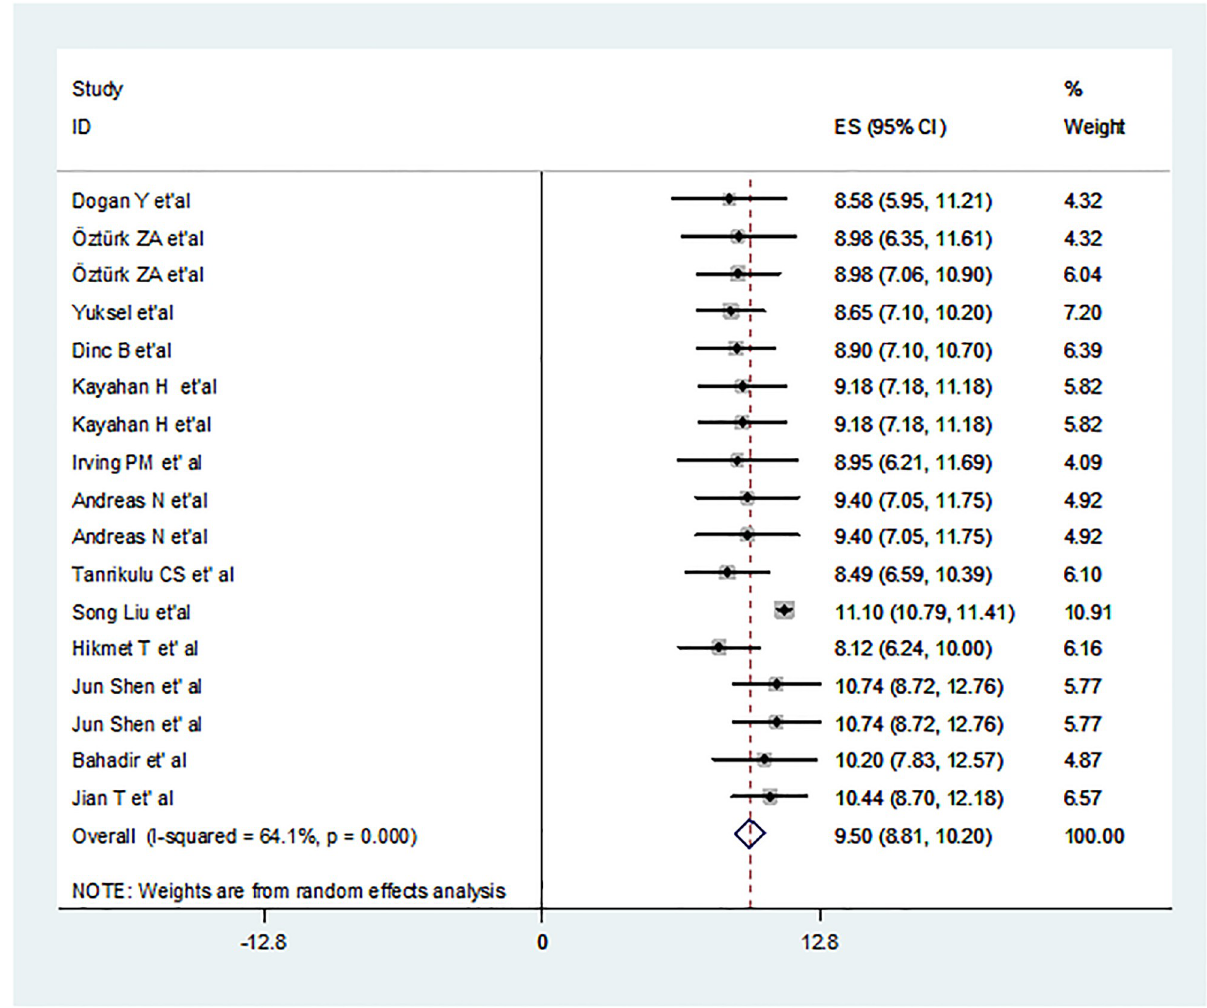
Fig 4. Forest plot of pooled estimated MPV in healthy controls. The size of the x-axis shows the estimate of pooled MPV of the studies. MPV is seen in the hard line (MPV = 0). In the pooled point calculation, the dotted line represents the MPV. The black dot in the middle of the gray box reflects the estimate pooled MPV of each studies point and the line shows the 95% CI of the estimates. The gray boxes represent each study weight that contributes to the estimation of the pooled MPV. I-squared illustrates the heterogeneity between the included studies.